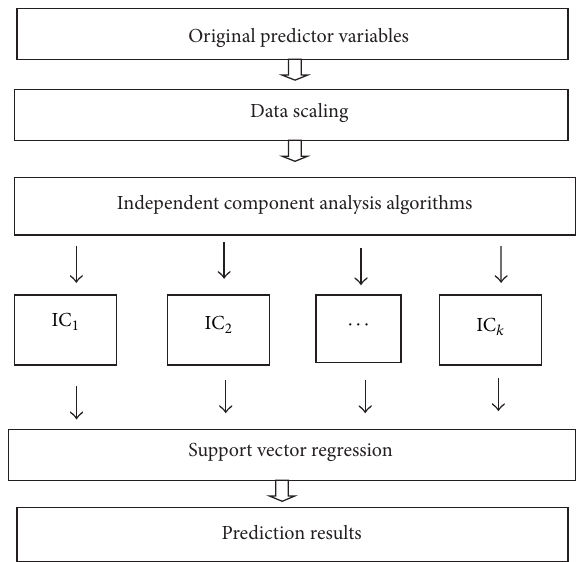
Figure 1: The proposed sales forecasting